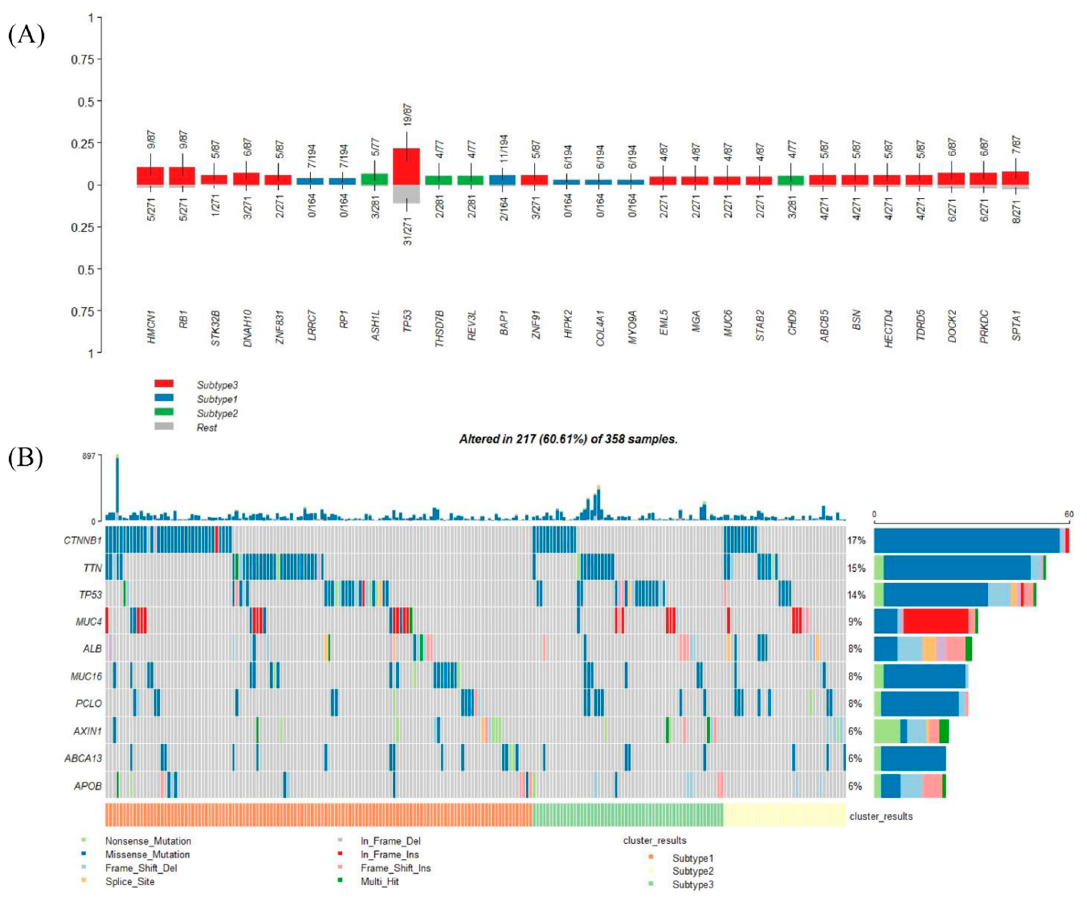
Figure 8. Mutation genes in different subtypes. ( A ) Mutation genes enriched in the different subtypes, ranked by the p -value of Fisher’s exact test. ( B ) Oncoplot showing the top 10 mutation genes in LIHC arranged by different subtypes.